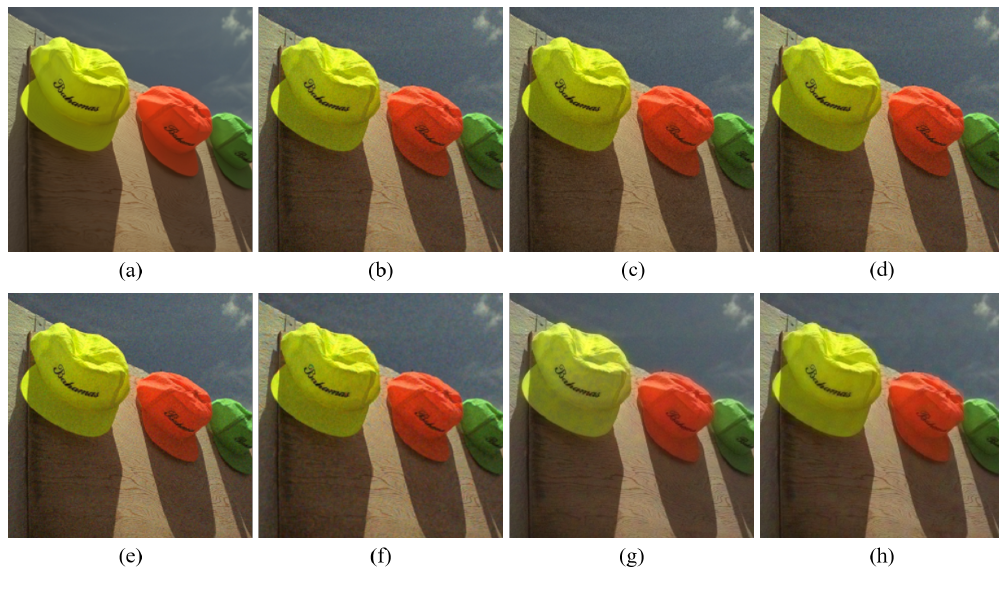
Figure 4. Demosaicing results of the Kodak No. 3 image under low-noise condition. ( a ) Original ( b )